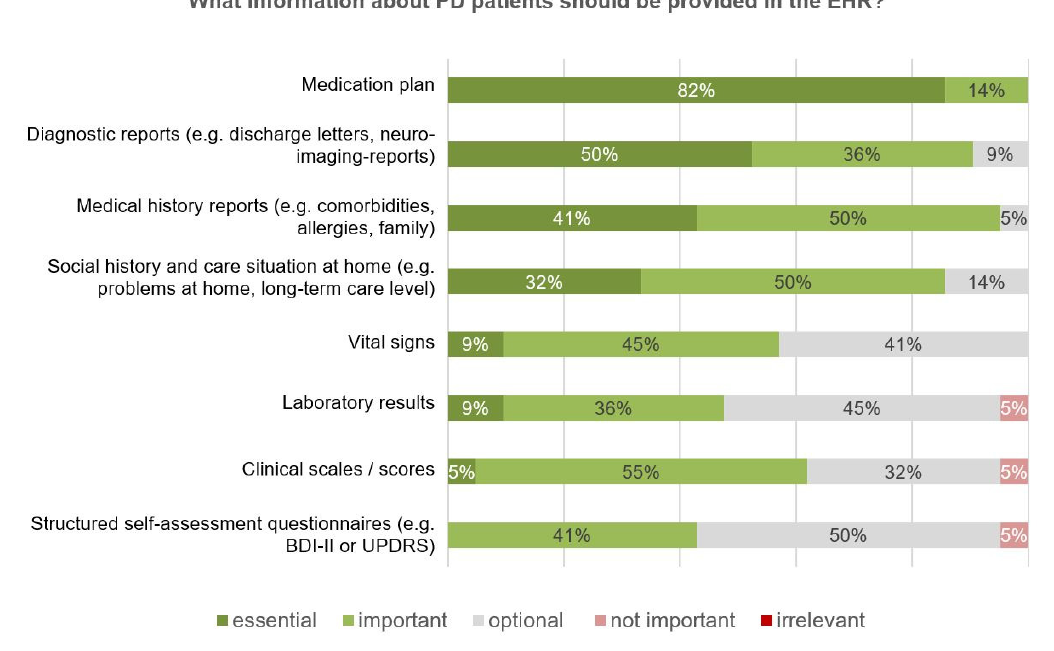
Figure 5. Survey results—information about PANOS patients provided in the electronic health record (EHR) ( n = 21).